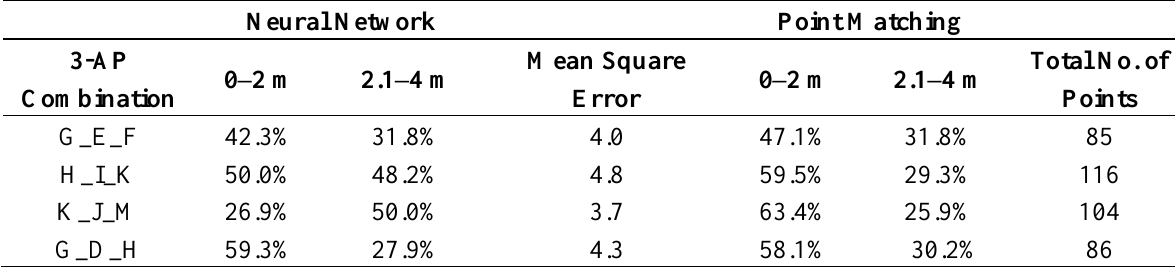
Table 3. Comparison of accuracy achievement between the neural network and the minimum point matching